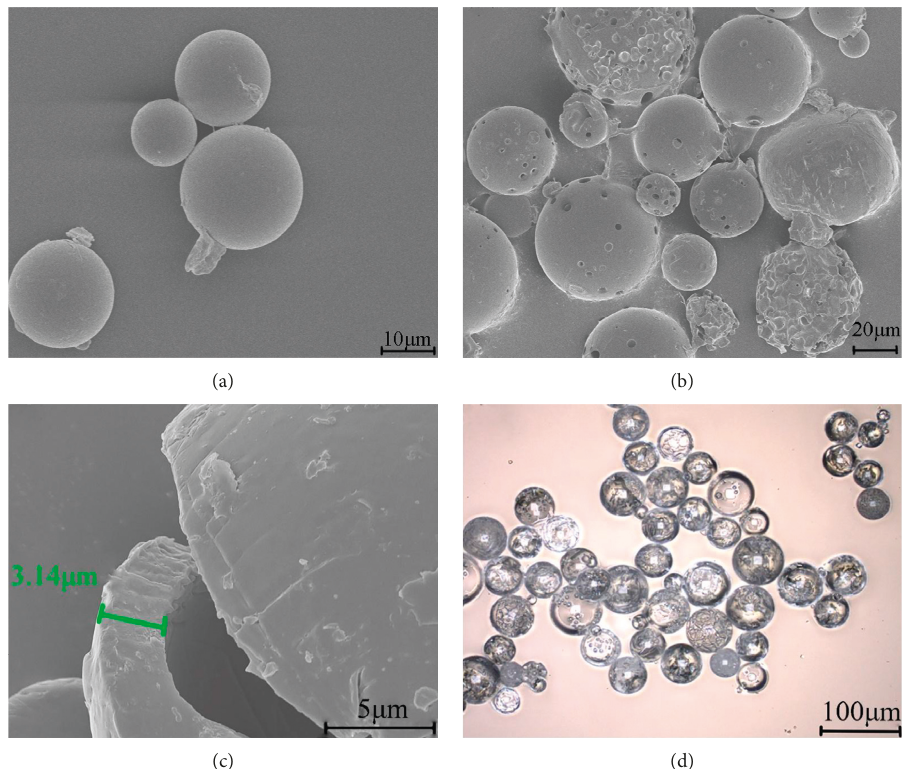
Figure 5: Images of microcapsules: (a) surfaces smooth and compact with defects, (b) rough and porous, (c) shell thickness, and (d) regular spherical